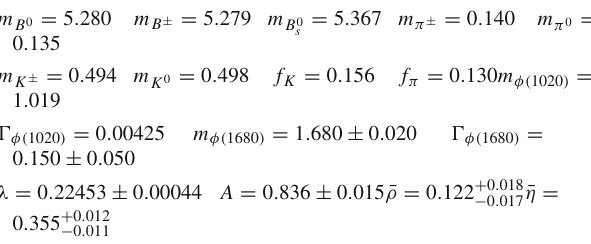
Table 1 Masses, decay constants, full widths of φ( 1020 ) and φ( 1680 ) (in units of GeV) and Wolfenstein parameters